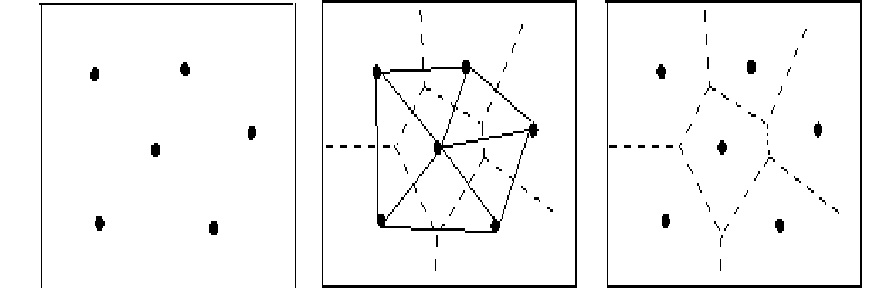
Figure 3. Implementation process of the Voronoi diagram.